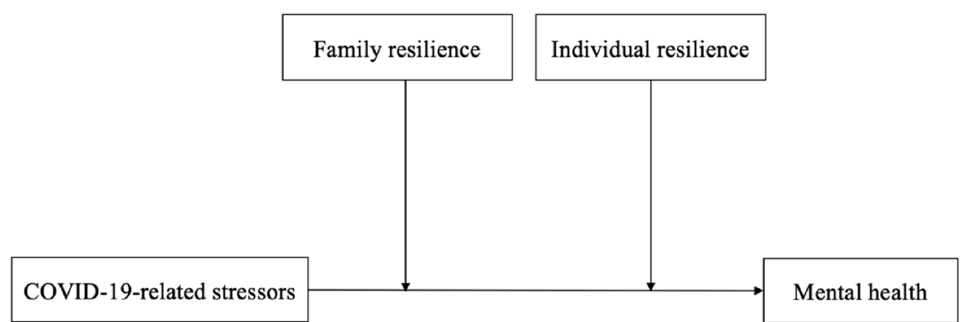
Figure 1. The proposed moderation models. Note: COVID-19-related stressors: COVID-19-related life disruptions and COVID-19-related psychological distress. Mental health: depression, anxiety and stress.